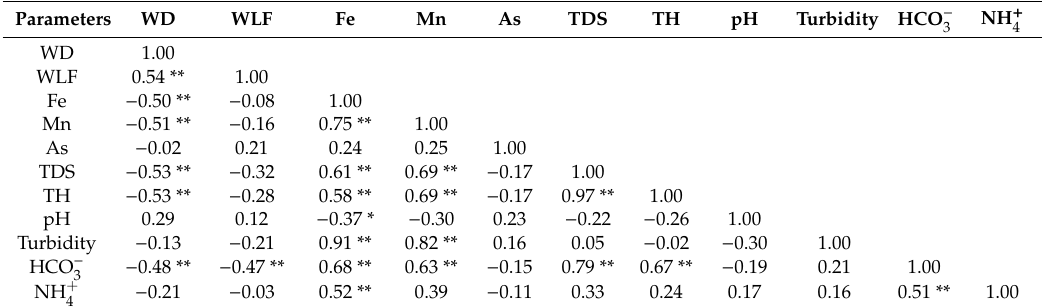
Table 3. Correlation of physio-chemical parameters and field observations with Fe and Mn concentrations (in the river valley).